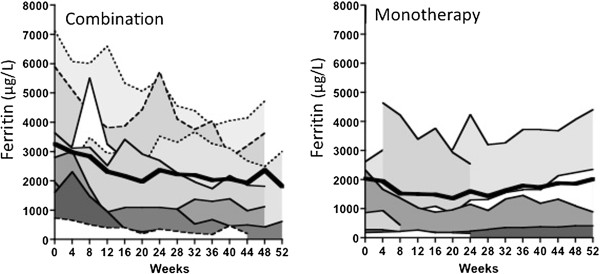
Baseline and 4 weekly ferritin values in DFP combination and DFO monotherapy arms for individual patients and mean (bold). With DFP combination, there is a significant downward trend from a baseline of 3308 ± 678 μg/L to 2371 ± 701 μg/L at 6 months (n = 9). Between baseline and 10–12 months, serum ferritin declined from 3601 ± 838 to 2132 ± 646 μg/L (n = 7). In the DFO monotherapy arm, there is a small downward trend from a baseline of 1880 ± 691 μg/L to 1603 ± 636 μg/L at 6 months (n = 6). In 4 samples at baseline and at 12 months, serum ferritin increased from 1613 ± 537 μg/L to 2018 ± 898 μg/L.